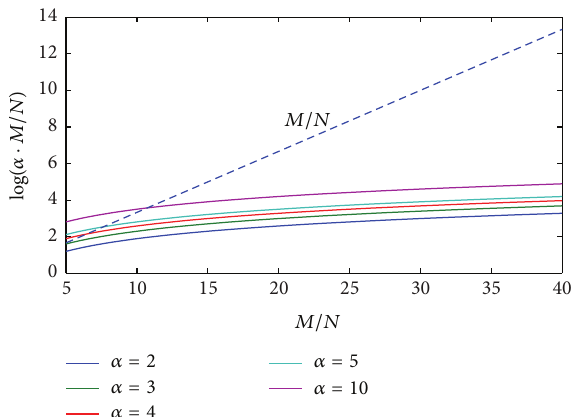
Figure 2: Behavior of (18) for the case 𝑁 = 3 , 𝛼 = 2, 3, 4, 5, 10 : ratio 𝑀/𝑁 is required to be between 11 and 15.